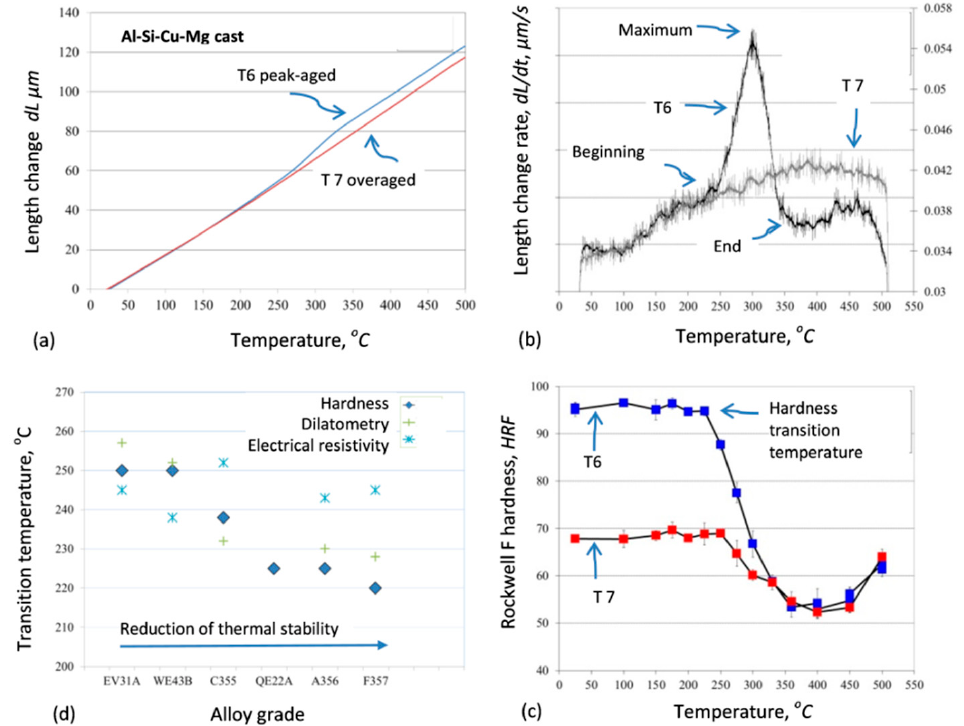
Figure 14. A methodology for determination of alloy thermal stability based on a combination of dilatometry and hardness measurements. Example for cast Al − Si − Cu − Mg alloy in T6 peak-aged and T7 over-aged conditions: ( a ) length change (dL) vs. temperature; ( b ) length change rate (dL / dt) vs. temperature; ( c ) hardness change versus temperature; ( d ) methodology application: thermal stability of commercial aluminum and magnesium alloys determined by hardness, dilatometry, and electrical resistivity measurements [51].